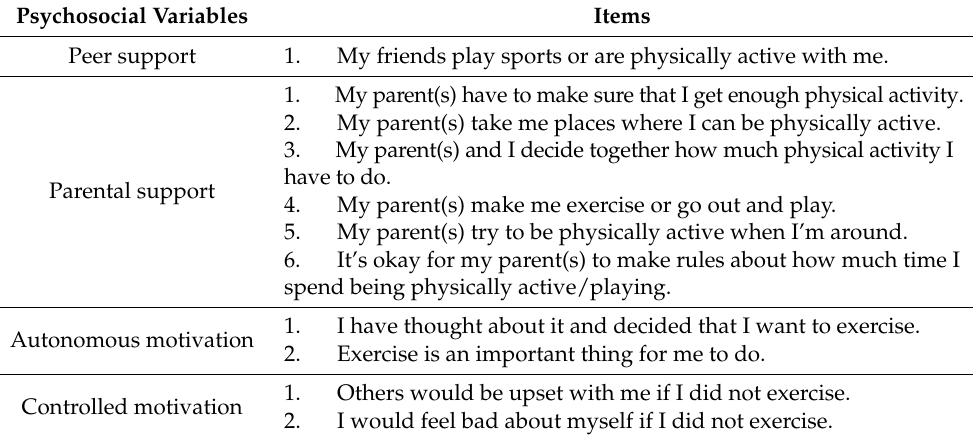
Table A1. Measures of the psychosocial